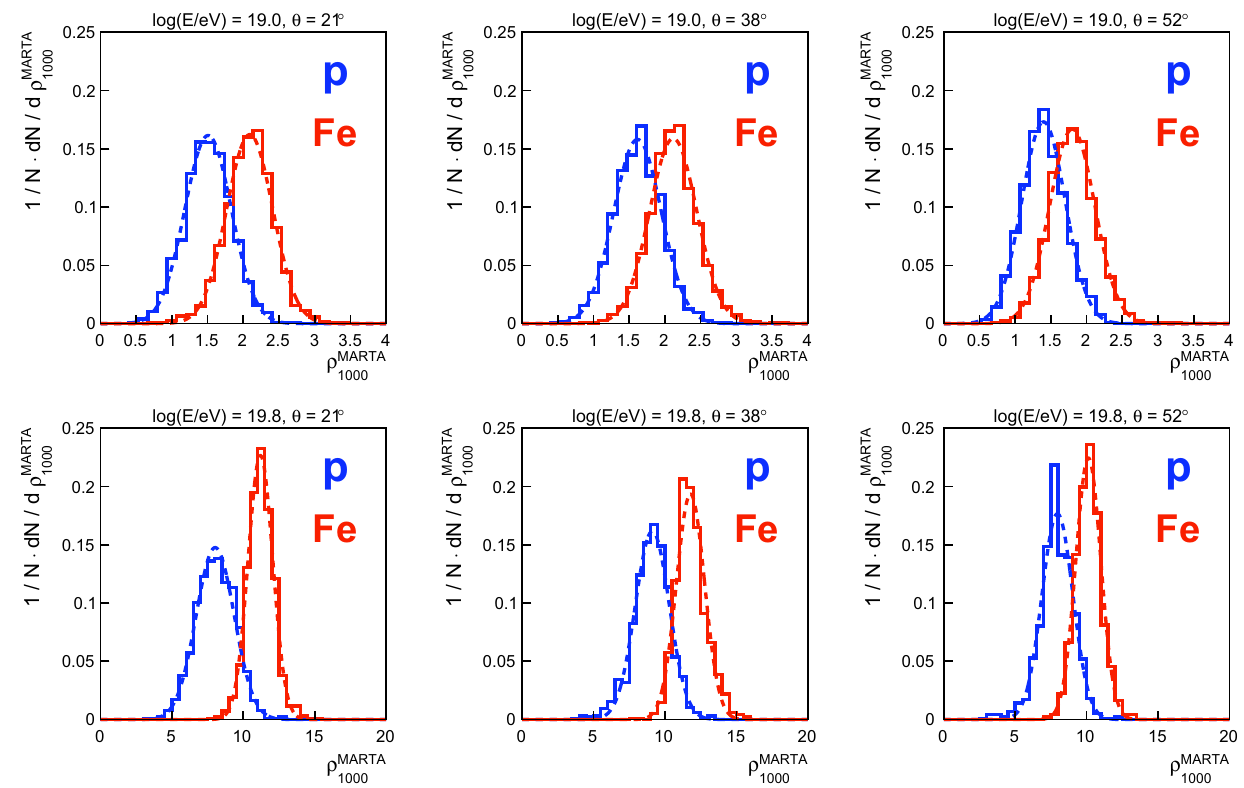
Fig. 10 ρ MARTA distributions for proton and iron primaries at different zenith angles (from left to right, θ = 21 ◦ , 38 ◦ , 52 ◦ with E = 10 19 eV (top 1000 plots) and E = 10 19 . 8 eV (bottom plots) obtained with QGSJET-II.04. Similar results were obtained with the EPOS-LHC interaction model